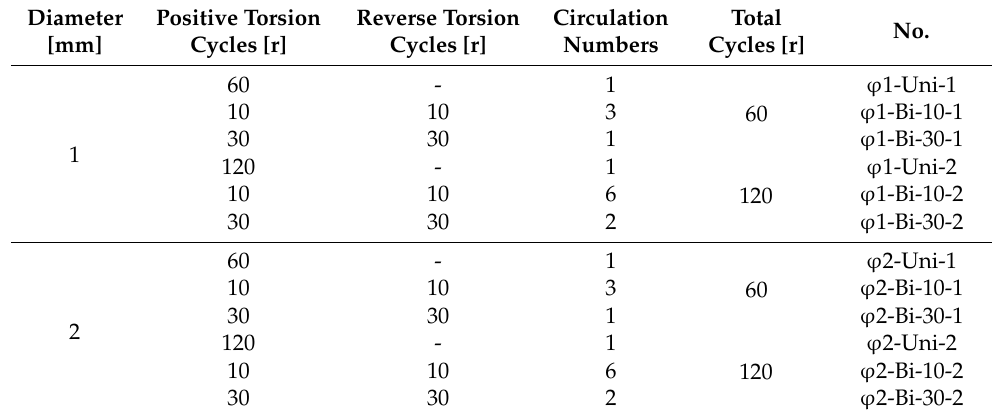
Table 1. Detailed sample numbers and corresponding deformation parameters.